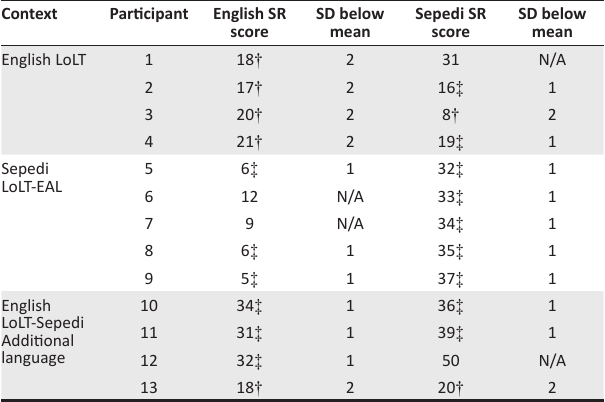
TABLE 4: Scores obtained by learners identified with specific language impairment in each educational context on the English and Sepedi sentence repetition